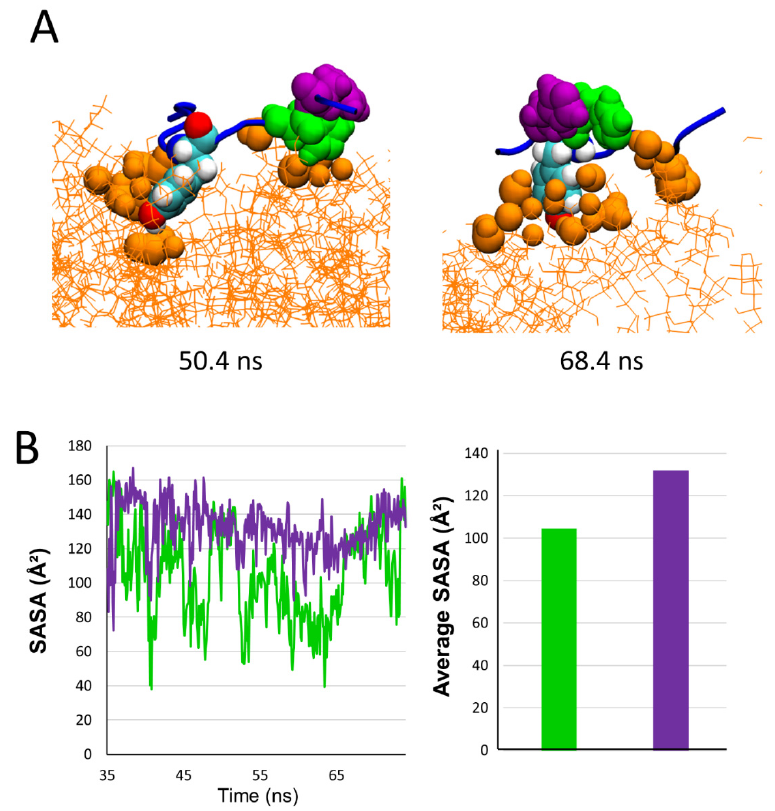
Figure 9. ( A ) Snapshot showing examples of conformations adopted by AmyP53 on the periphery of the lipid raft. GM1 are depicted as orange lines and GM1 atoms that are between 0 and 3 Å of protein are depicted as orange spheres. ( B ) Plot presenting the evolution of SASA over time for H9 (green line/histogram) and H10 (purple line/histogram) at the late stage, and histogram presenting the average SASA.